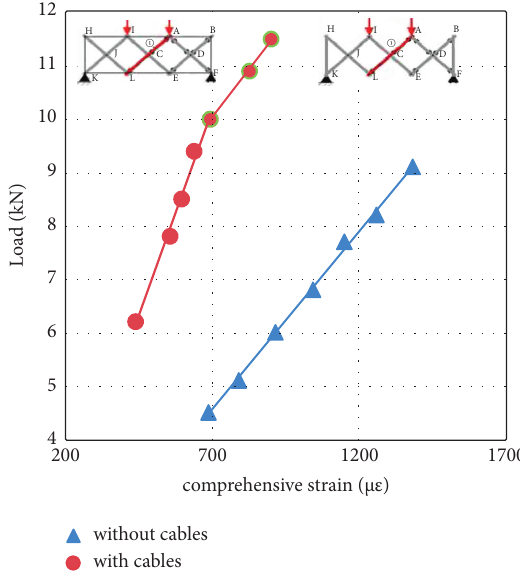
Figure 17: Comparison of the comprehensive strain of structures with and without steel